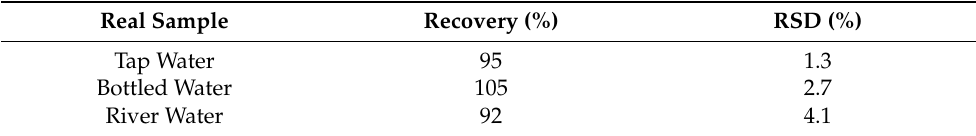
Table 3. Determination of BPA in real water samples ( n